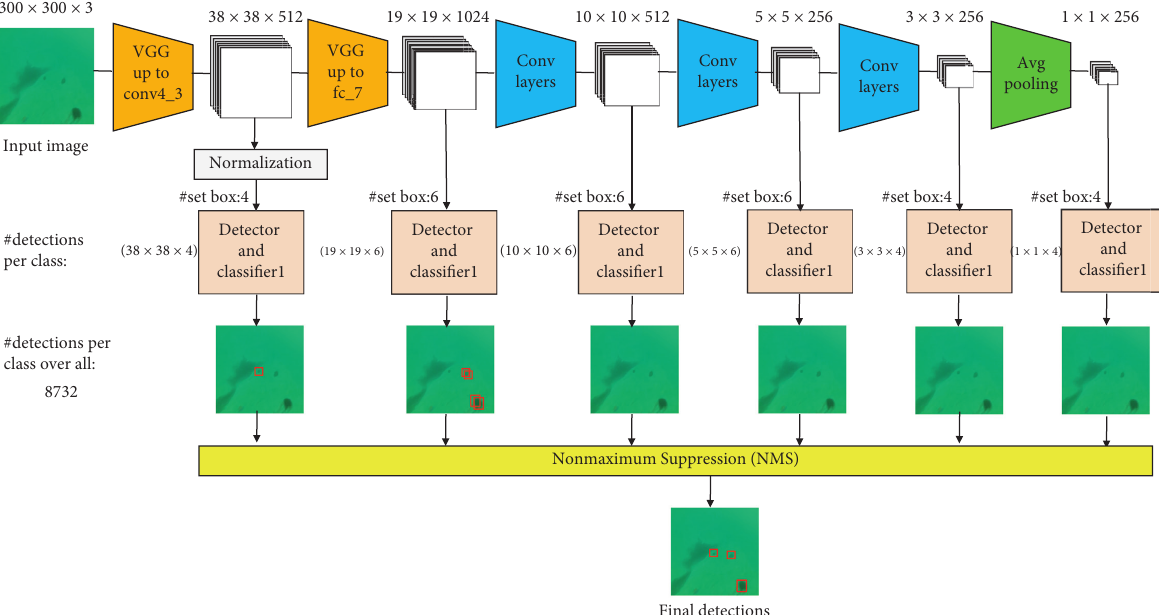
Figure 1: SSD structure frame.